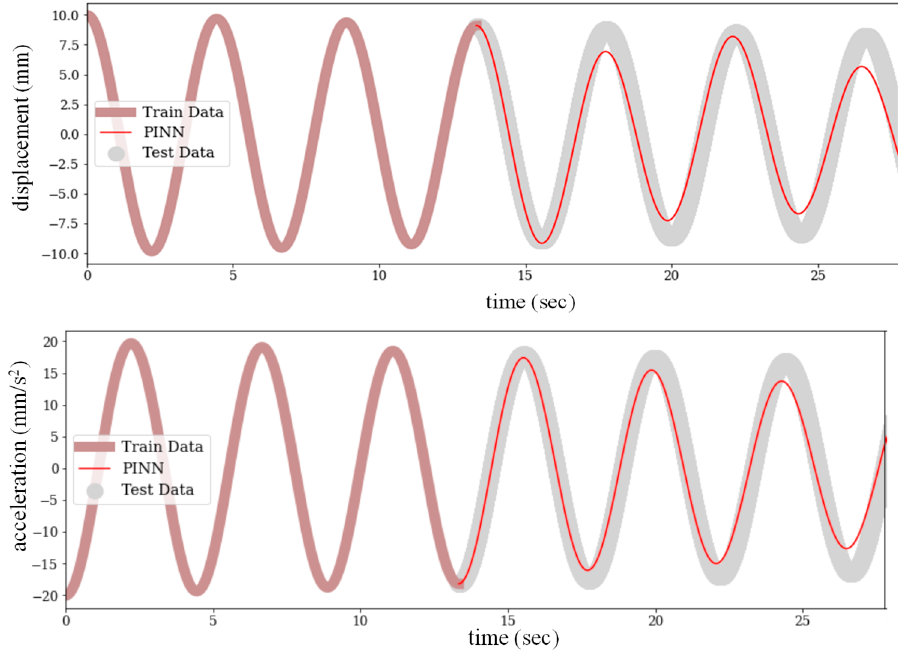
Figure 9. Displacement and acceleration estimation of the SDOF trained by acceleration measure ‐ ments.